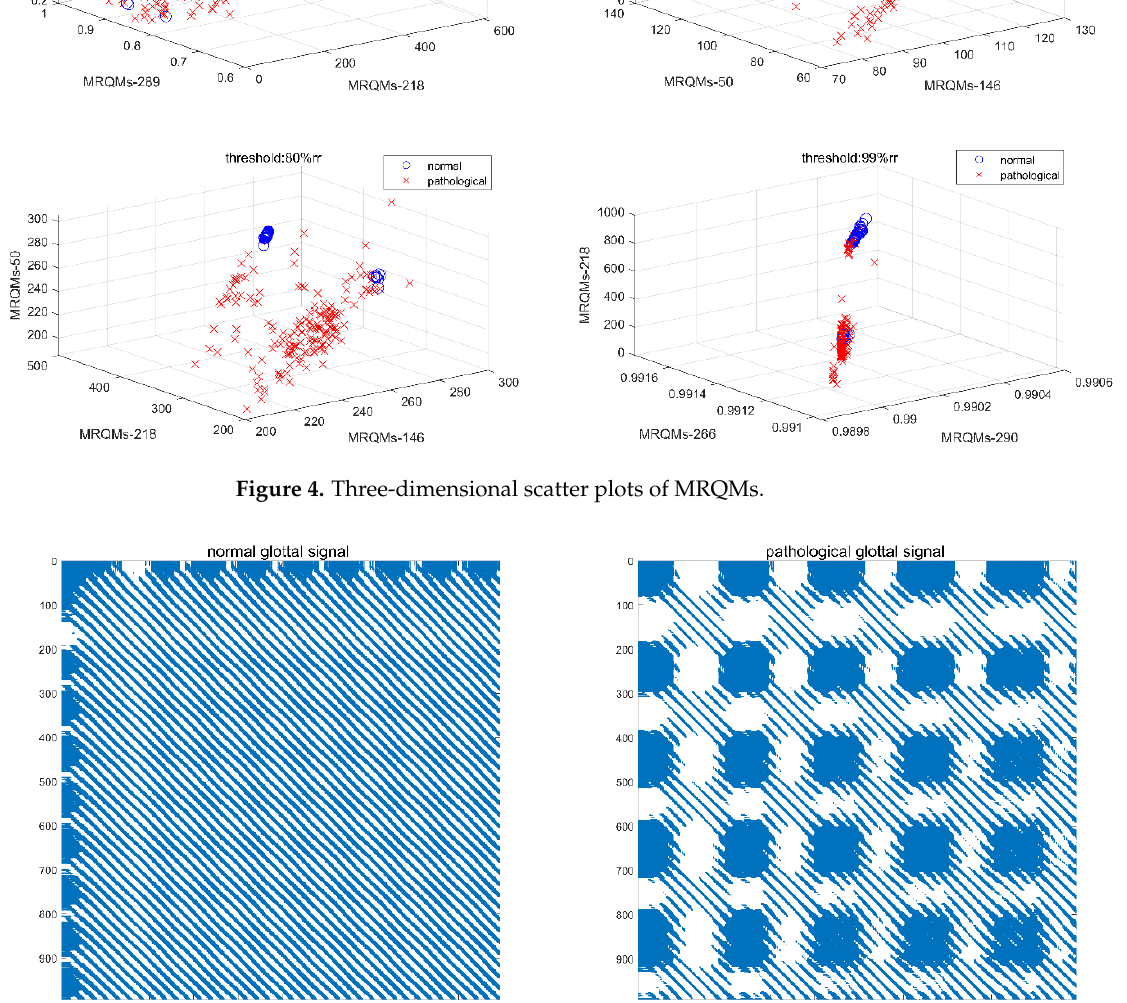
Figure 4. Three-dimensional scatter plots of MRQMs.